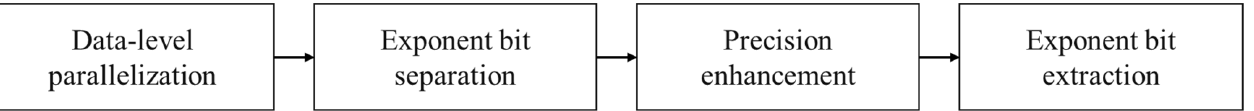
Figure 2. Block diagram of the processing modules in the proposed method.